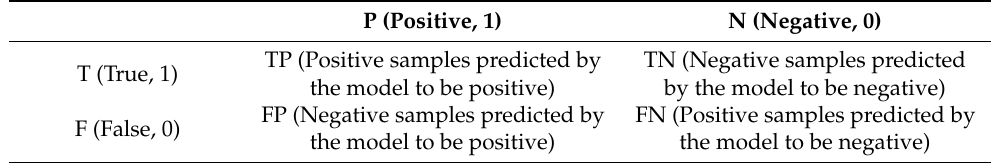
Table 6. Specific definitions of TP, TN, FP, and FN.